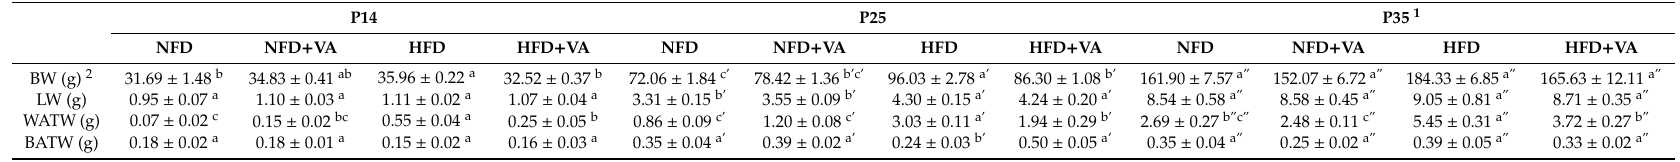
Table 1. Body weight and weights of the liver, visceral white adipose tissue, and brown adipose tissue of rat pups at postnatal day 14, postnatal day 25, and postnatal day